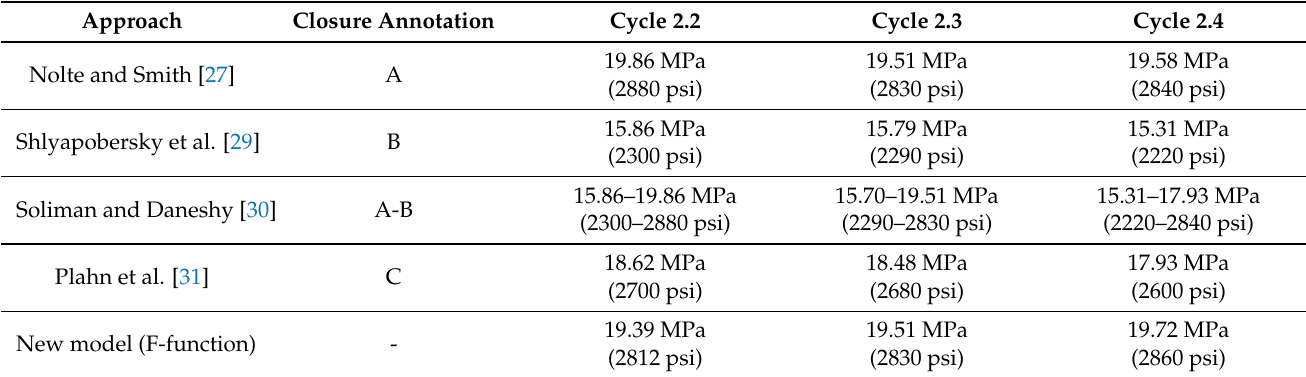
Table 8. Analysis summary of test 8 flowback